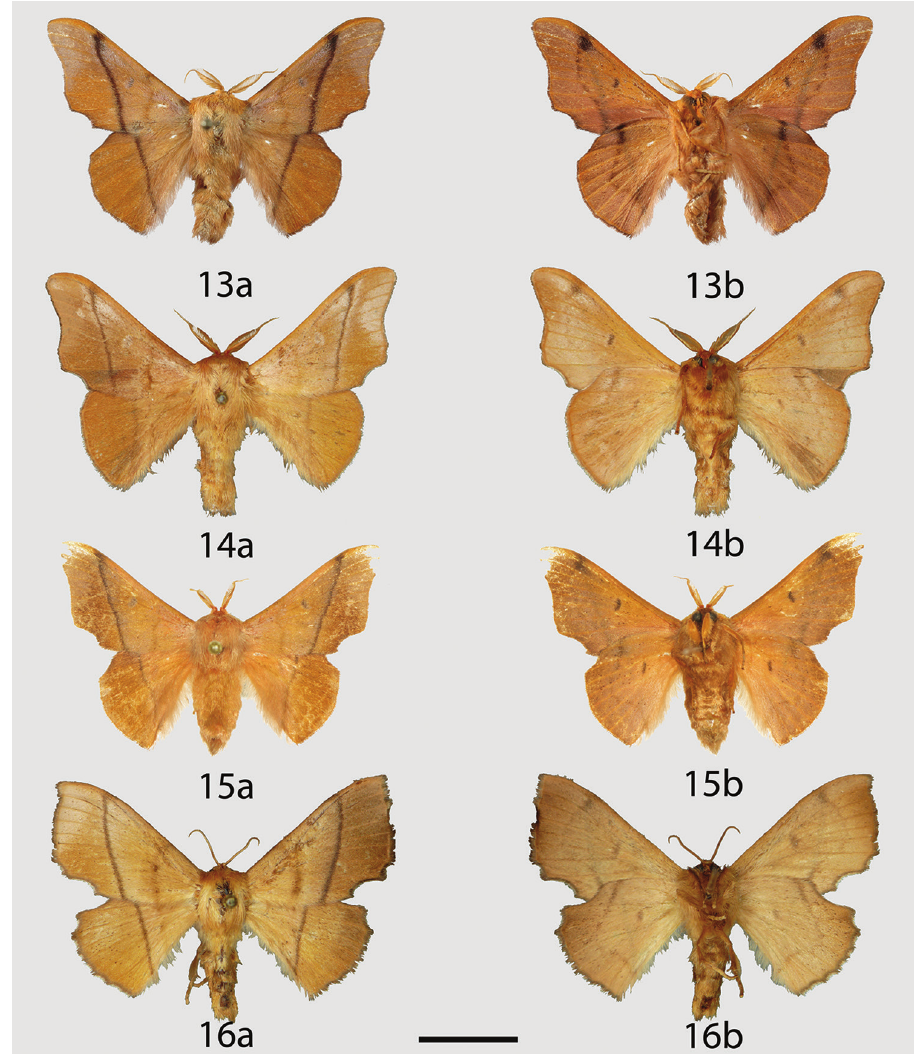
Figures 13–16. Reinmara wolfei adults, a dorsal b ventral. 13 Holotype ♂ , Brazil, Maranhão, Feira Nova do Maranhão, 480 m [image originally published by Antenor, reused with permission] (DZUP) 14 ♂ , Brazil, Distrito Federal, Planaltina, 1000 m (CPAC) 15 ♂ , Brazil, Mato Grasso, 60 km S. of Poconé, Pantanal, 100 m (USNM) 16 ♀ , Locality as for Fig. 14 (CPAC). Scale bar: 1